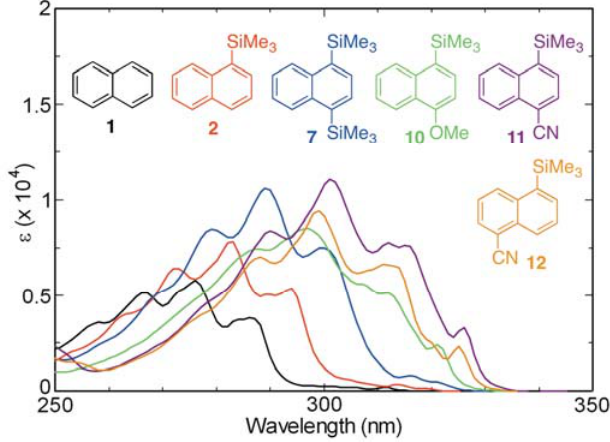
Figure 6. UV absorption spectra of 1 , 2 , 7 , and 10–12 in cyclohexane (aerated, ca. 10 − 4